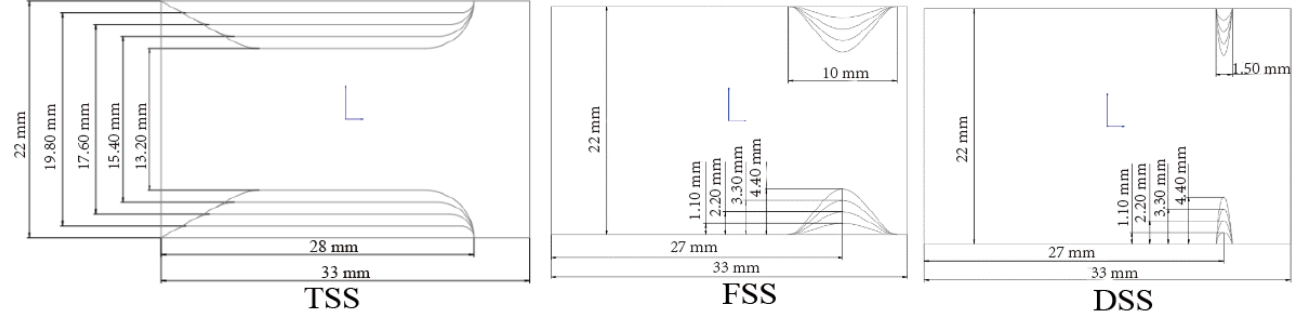
Figure 2. Model geometry with dimensions for three types of SAS (obstruction height: 1.1, 2.2, 3.3, and 4.4 mm).